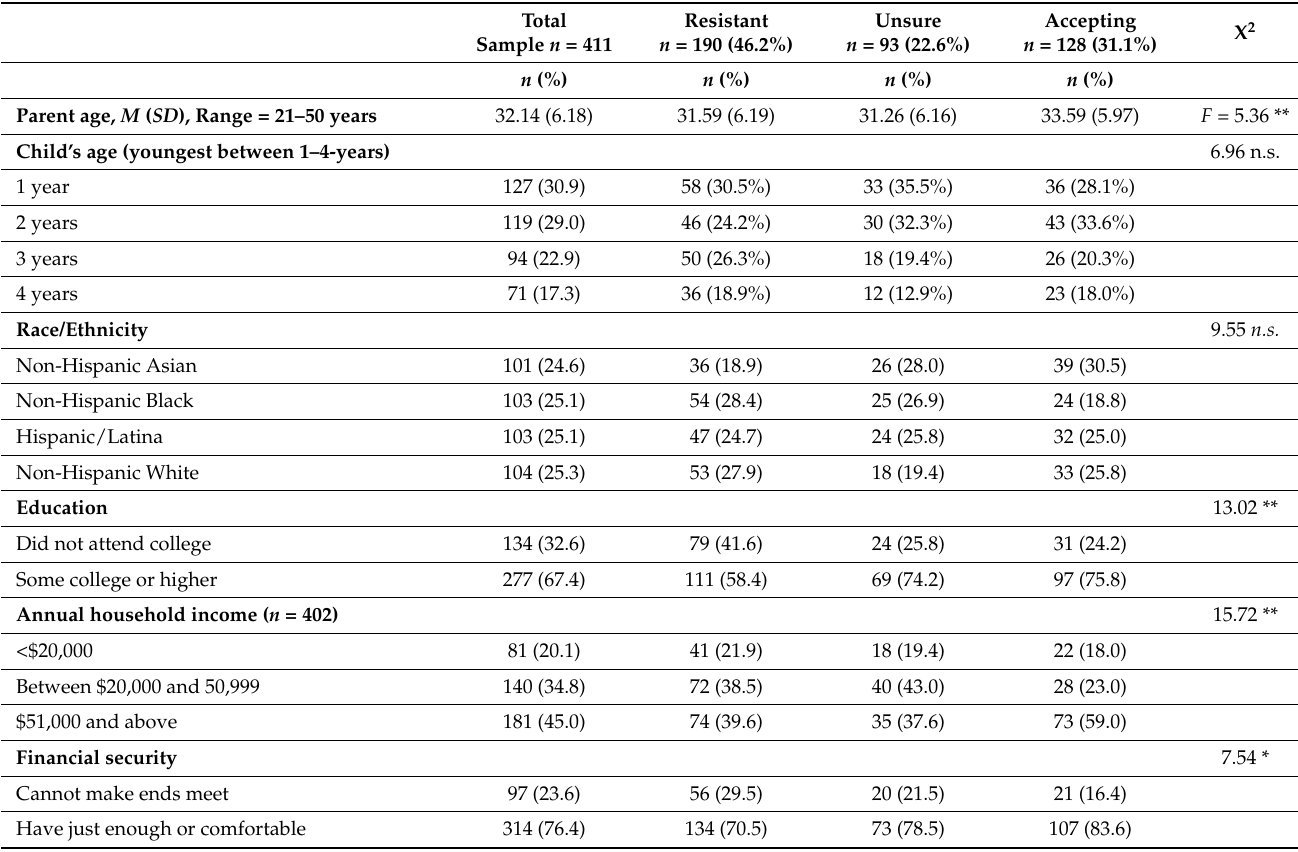
Table 1. Frequencies/percentages and means/standard deviations for parental demographic charac- teristics and non-parametric analyses across vaccine intent